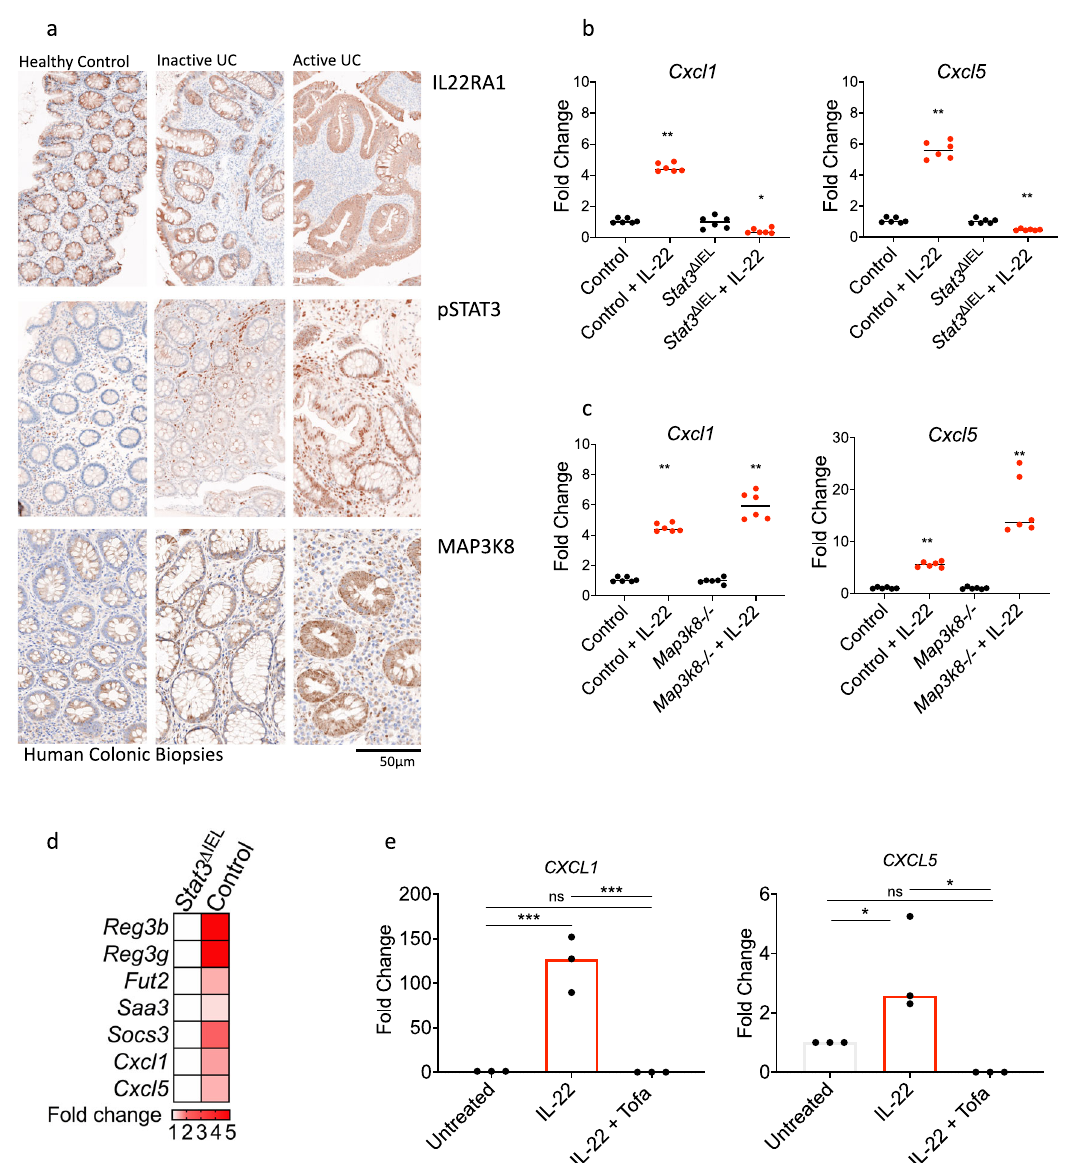
Fig. 7 | IL-22 mediated induction of neutrophil-active chemokines in colonic epithelial cells is abrogated by JAK inhibition. a Representative images of immunostaining for IL22RA1, pSTAT3 and MAP3K8 in the colon of a healthy con- trol, UC patient without active in fl ammation and a UC patients with active in fl am- mation, b , c relative expression of Cxcl1 and Cxcl5 in IL-22 treated colonoids generated from Villin -Cre x Stat3 fl / fl mice (Stat3 Δ IEL ), Map3k8 − / − mice and controls,